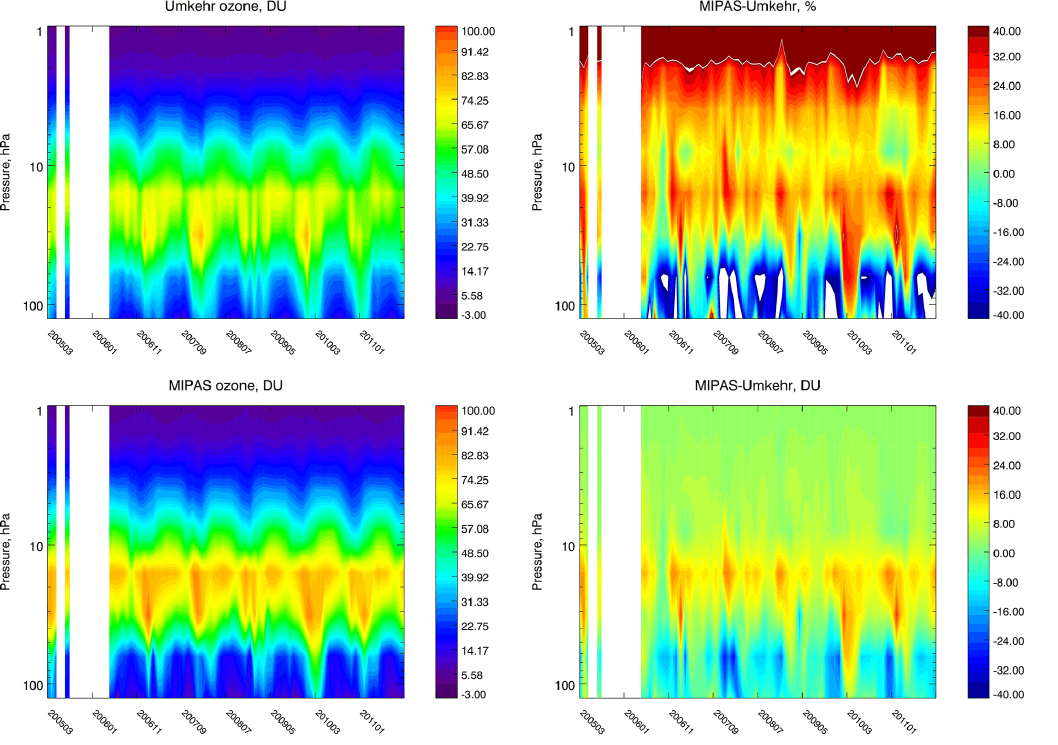
Figure 10. Monthly mean ozone values (in DU) of Umkehr (top left panel) and MIPAS (bottom left panel) and monthly means of relative (top right panel) and absolute (bottom right panel) MIPAS–Umkehr differences in 2005–2012 at Boulder station (# 067), 40 ◦ N.